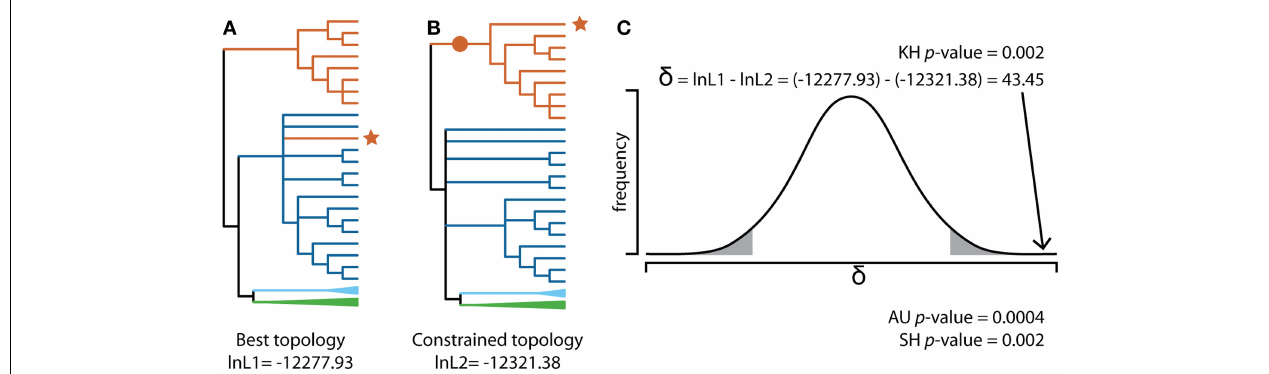
FIGURE 3 | Evaluating HGT using a comparative topology test. (A) Maximum likelihood (ML) phylogeny of homologous sequences to stcI, a gene in the sterigmatocystin SM cluster, in Podospora anserina identified from a BLAST search of 161 Pezizomycotina genomes (JGI Mycocosm, download date 5 July 2014). Sequences were aligned and trimmed using MAFFT (Katoh and Standley, 2013) and trimAL (Capella-Gutierrez et al., 2009), respectively, and the phylogeny was created using RAxML (Stamatakis, 2014) using the PROTGAMMAAUTOF amino acid model of substitution and 100 bootstrap replicates. The resulting cladogram was midpoint rooted and branches supported by less than fifty bootstrap replicates were collapsed. This ML best tree depicts Podospora anserina (Sordariomycetes; red branch with red (cid:2) ) grouping with Eurotiomycetes (dark blue branches). Other taxa in the phylogeny include additional Sordariomycetes (red branches), Leotiomycetes (light blue collapsed clade) and Dothideomycetes (green collapsed clade). (B) Best ML phylogeny using the same input data, but with the constraint imposed that Podospora anserina must group